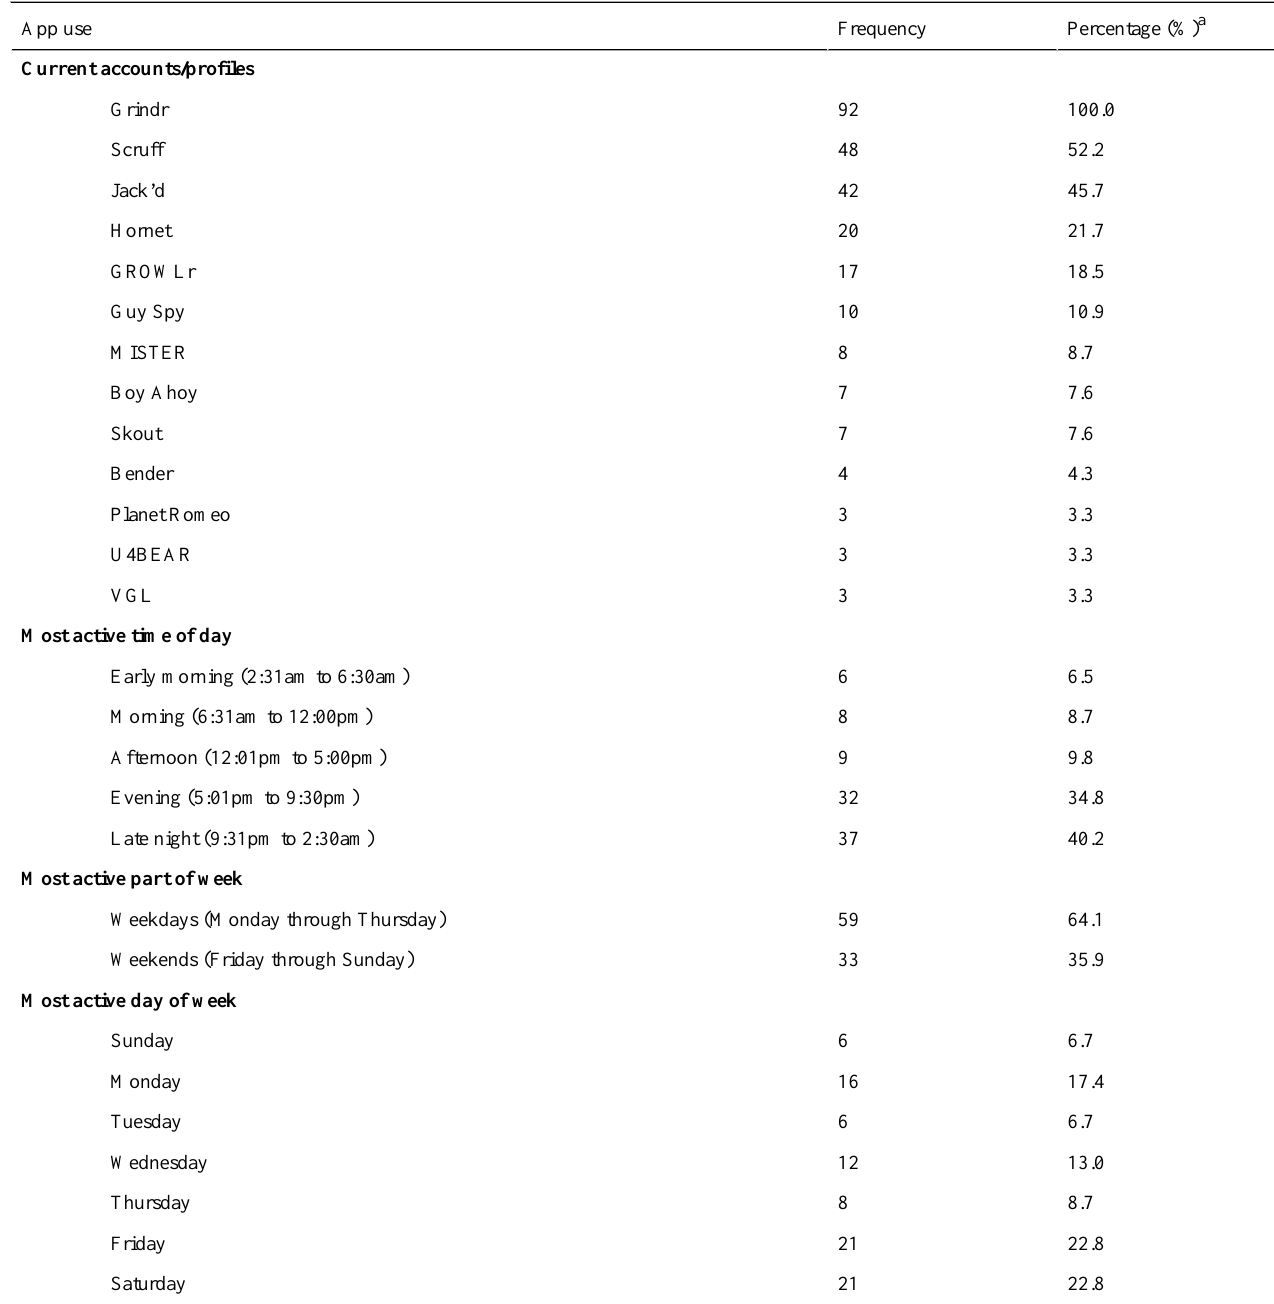
Table 2. Geosocial-networking app use (categorical